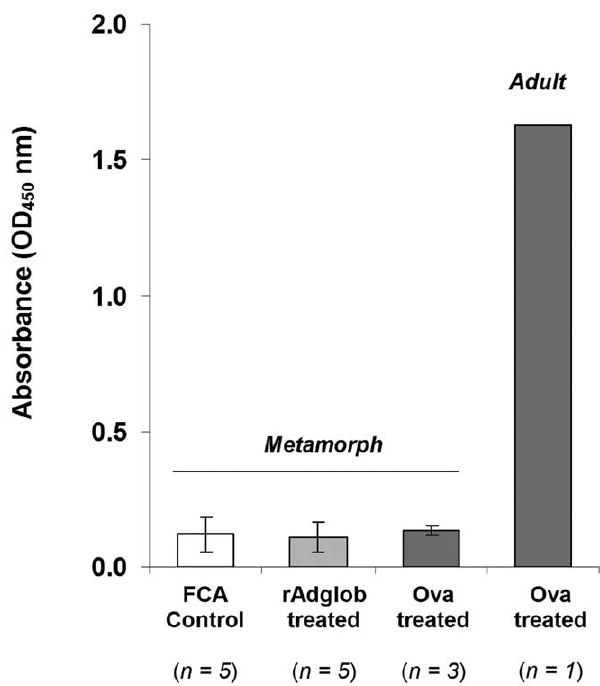
Figure 5. IgG antibody response to globin antigen not detected in metamorphs by ELISA. IgG levels as measured by ELISA in metamorphs (stage 46) injected with adult globin (rAdglob treated) compared with untreated metamorphs (FCA control). Positive controls show IgG levels in metamorphs and an adult injected with ovalbumin. Sera from rAdglob treated and FCA control animals used at 1:80; ovalbumin treated metamorph sera used at 1:320; ovalbumin treated adult sera used at 1:1000.